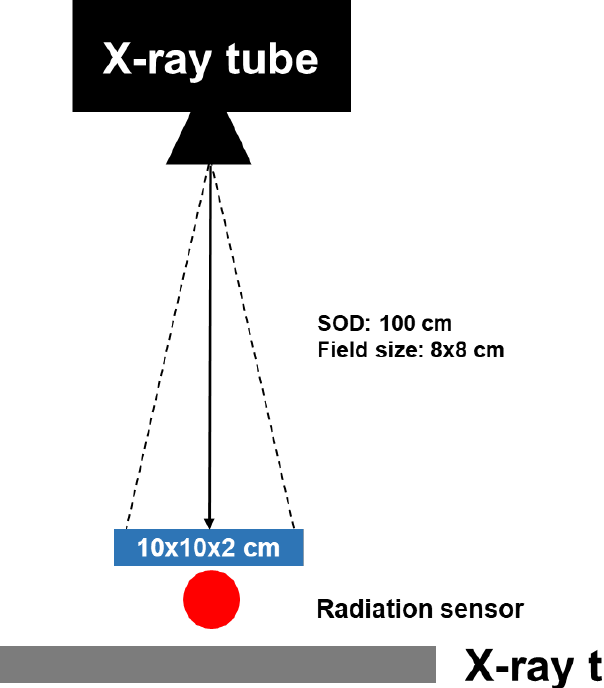
Figure 1. Schematic view of the X-ray radiation shielding tests.